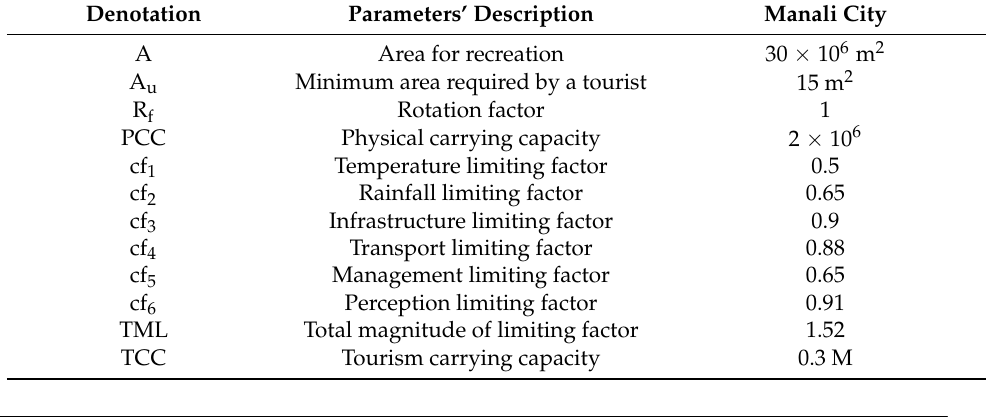
Table 6. Estimation of Tourism Carrying Capacity of Manali.